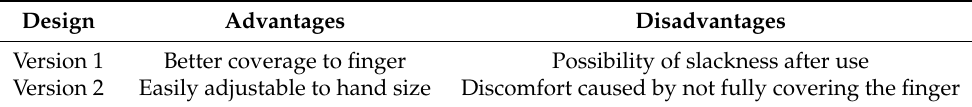
Figure 2. Different versions of wearable finger sensors: ( a ) Version 1 and ( b ) Version 2. Table 1. The advantages and disadvantages of the finger sensor